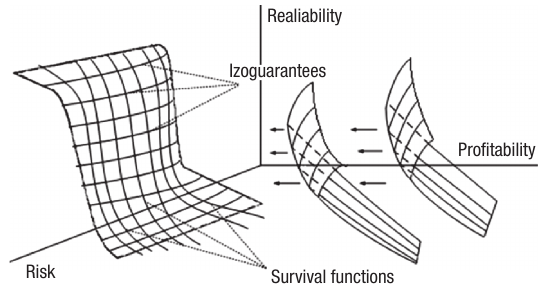
Fig. 3. Search for intersection of effectiveness zone (left side) and utility function (right side) of general value at risk reduction